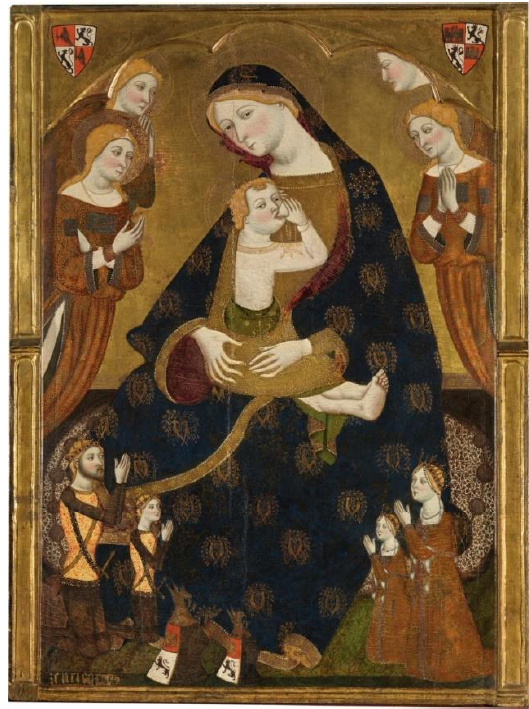
Figure 1. Jaume Serra. The Virgin of Tobed with the Donors Henry II of Castile, his Wife Juana Manuel, and two of their Children, Juan and Juana. (Lembrí 2022) © Museo Nacional del Prado.